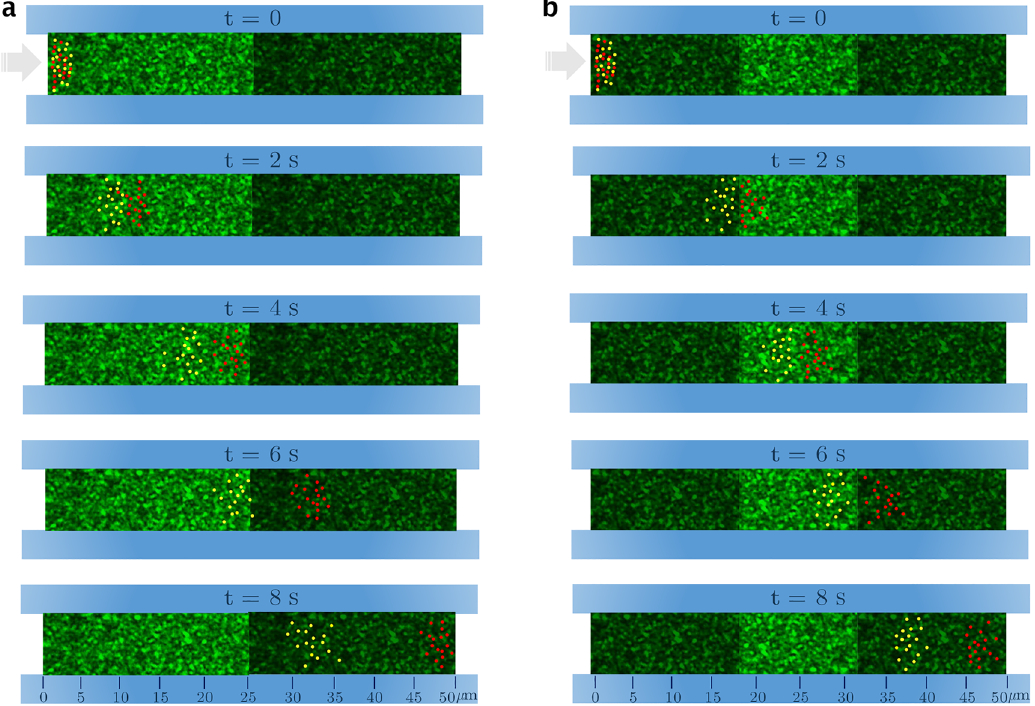
Figure 5: Microfluidic speckle filtering of NP-loaded liposome (gold color dots) from the empty ones (red dots), based on their velocity hindering in varying speckle intensity. The average speckle intensity is changed (from ⟨ I ⟩ = 6 . 2 μ W/ μ m 2 to ⟨ I ⟩ = 0 . 93 μ W/ μ m 2 , or vice versa) in (a) one and (b) two boundaries. Sample time lapses belong to every 2 s and the process takes a time duration of about 8